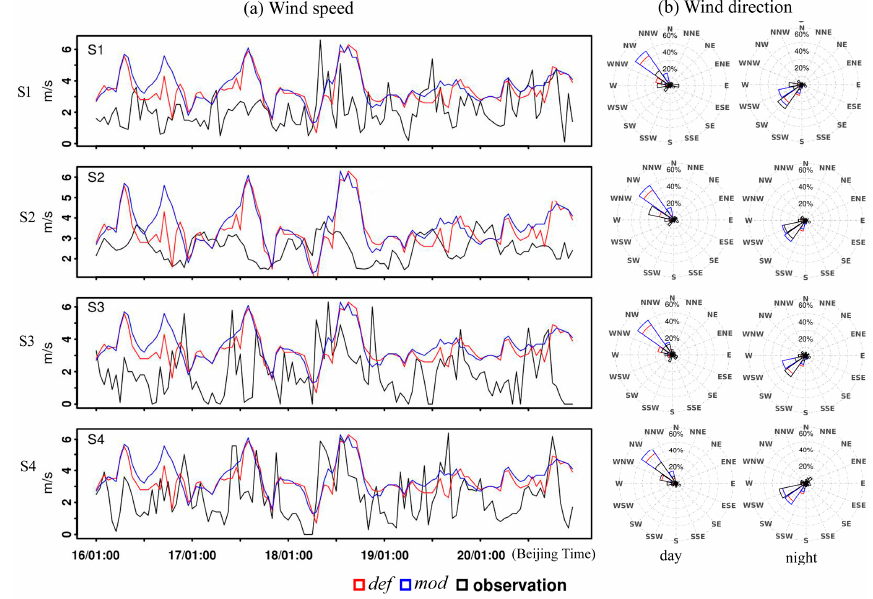
Figure 5. Comparison between the observed and simulated ( a ) wind speed (W S ) and ( b ) wind direction (W D ) from the mod and def simulations at the four stations (S1, S2, S3 and S4) during 16 July to 20 July.